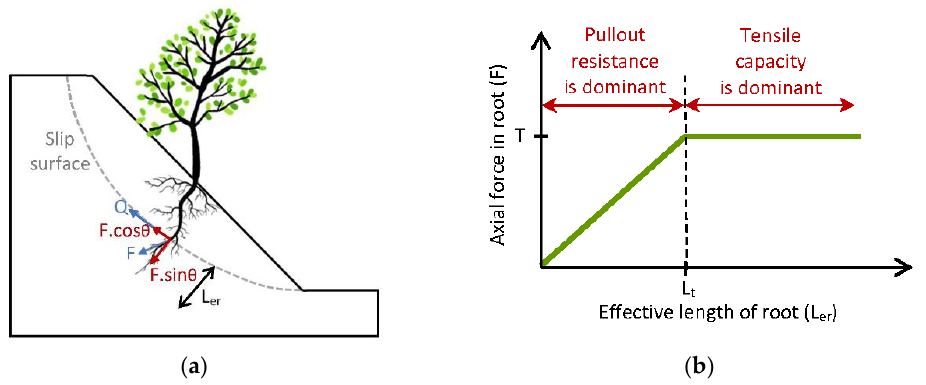
Figure 3. ( a ) Schematic view of soil–root interaction model; ( b ) the dominant mechanism in root reinforcement (adapted from Zhu, et al.